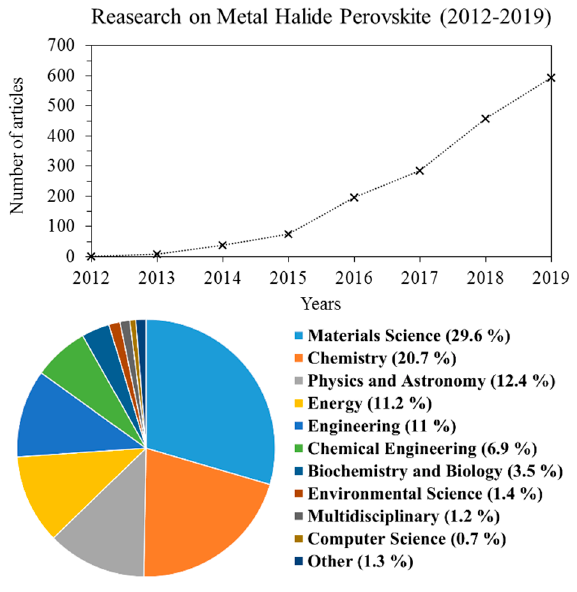
Figure 3. Trends of the published scientific articles on metal halide perovskites and academic trends. Analysis search results by Scopus.com.